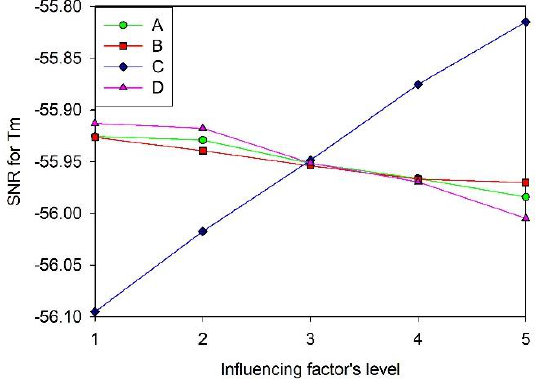
ff ect diagram of SNR at di ff erent levels for Tm Figure 15. Effect diagram of SNR at different levels for Tm. Figure 15. E